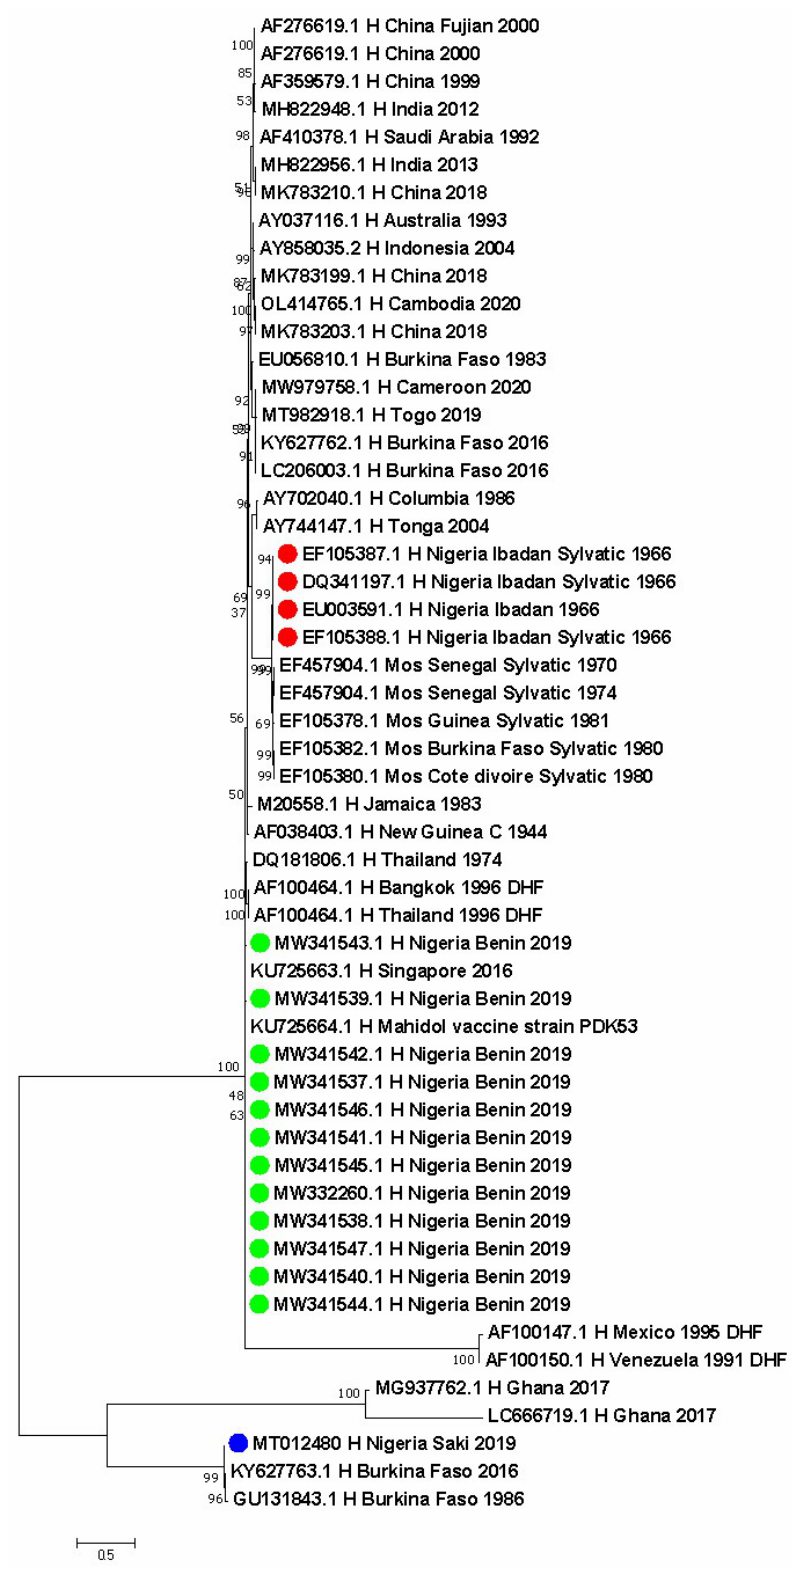
Figure 2. Evolutionary relationships of DENV-2 isolates from Nigeria compared with strains from other parts of the world. Dots are the specific locations in Nigeria. Red dot is the genotype VI Sylvatic strain (Ibadan, Oyo State), green is the genotype V Asian I (Benin, Edo State), and blue is the genotype II Cosmopolitan strain (Saki, Oyo State).